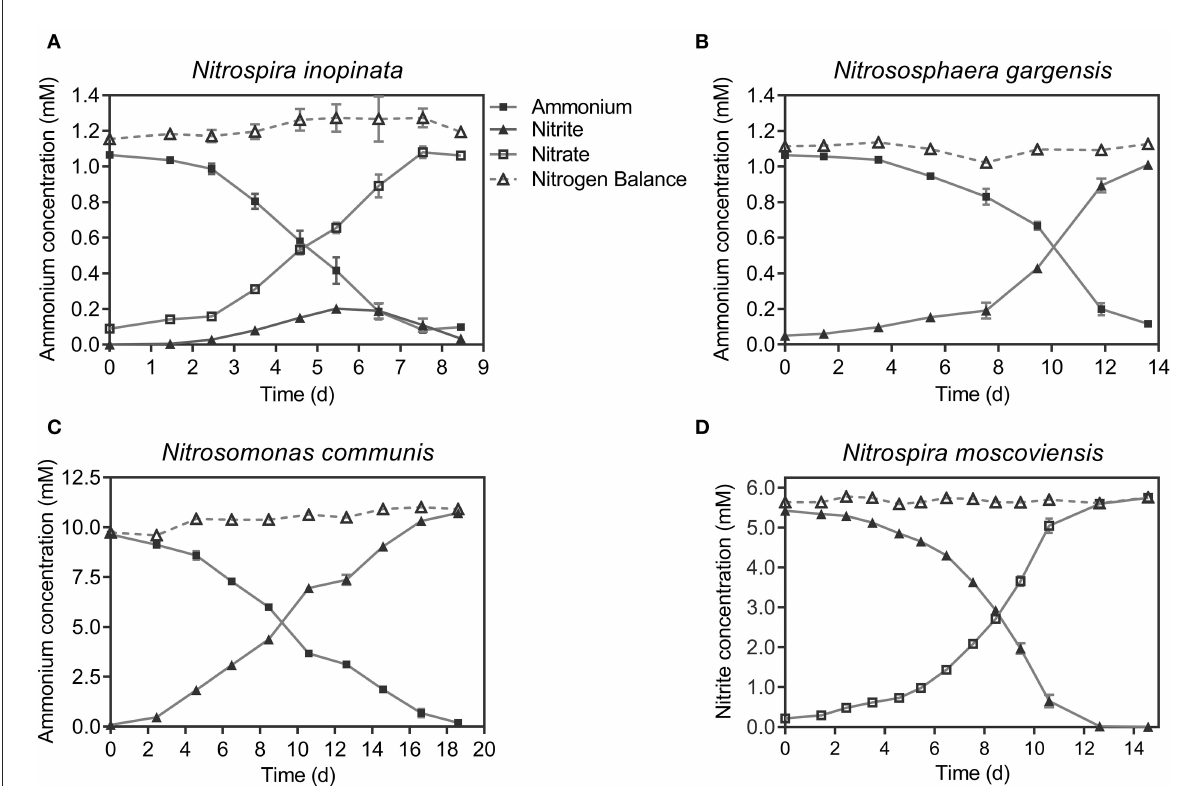
FIGURE2 Ammonium or nitrite consumption and nitrite or nitrate production by nitrifiers grown at the unified medium at 37 ◦ C. (A) comammox ( N. inopinata ); (B) AOA ( N. gargensis ); (C) AOB ( N. communis ); (D) NOB ( N. moscoviensis ) at the exponential stage without quantifying the cell number were inoculated to fresh medium. The substrate concentrations were 1, 1, 10, and 5.7mM, respectively. Data points are shown as mean ± SE ( n = 5). If not visible, error bars were smaller than